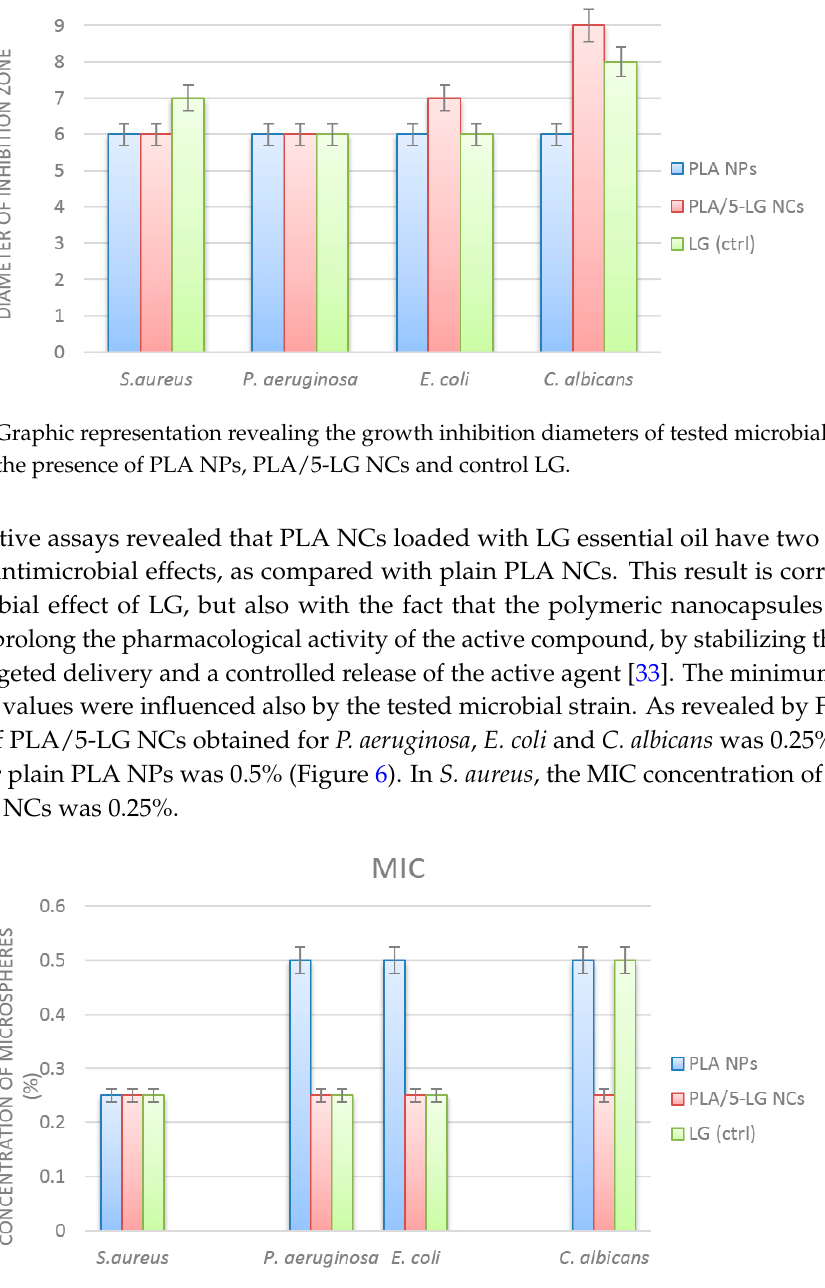
Figure 6. Graphic representation revealing the minimum inhibitory concentration values (MICs) of PLA NPs, PLA/5-LG NCs and control LG oil on the tested microbial strains after 24 h or incubation.